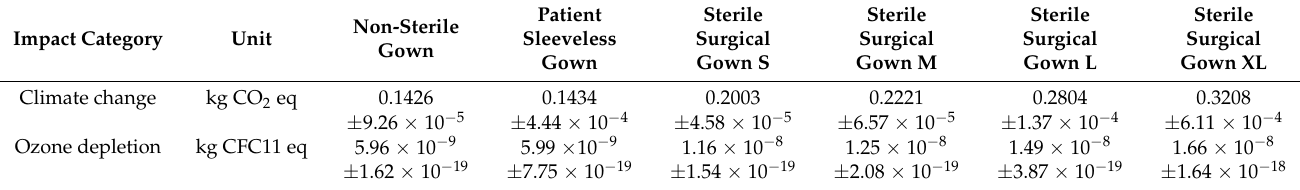
Table 3. Environmental Footprint characterization of the single-use nonwoven (Part